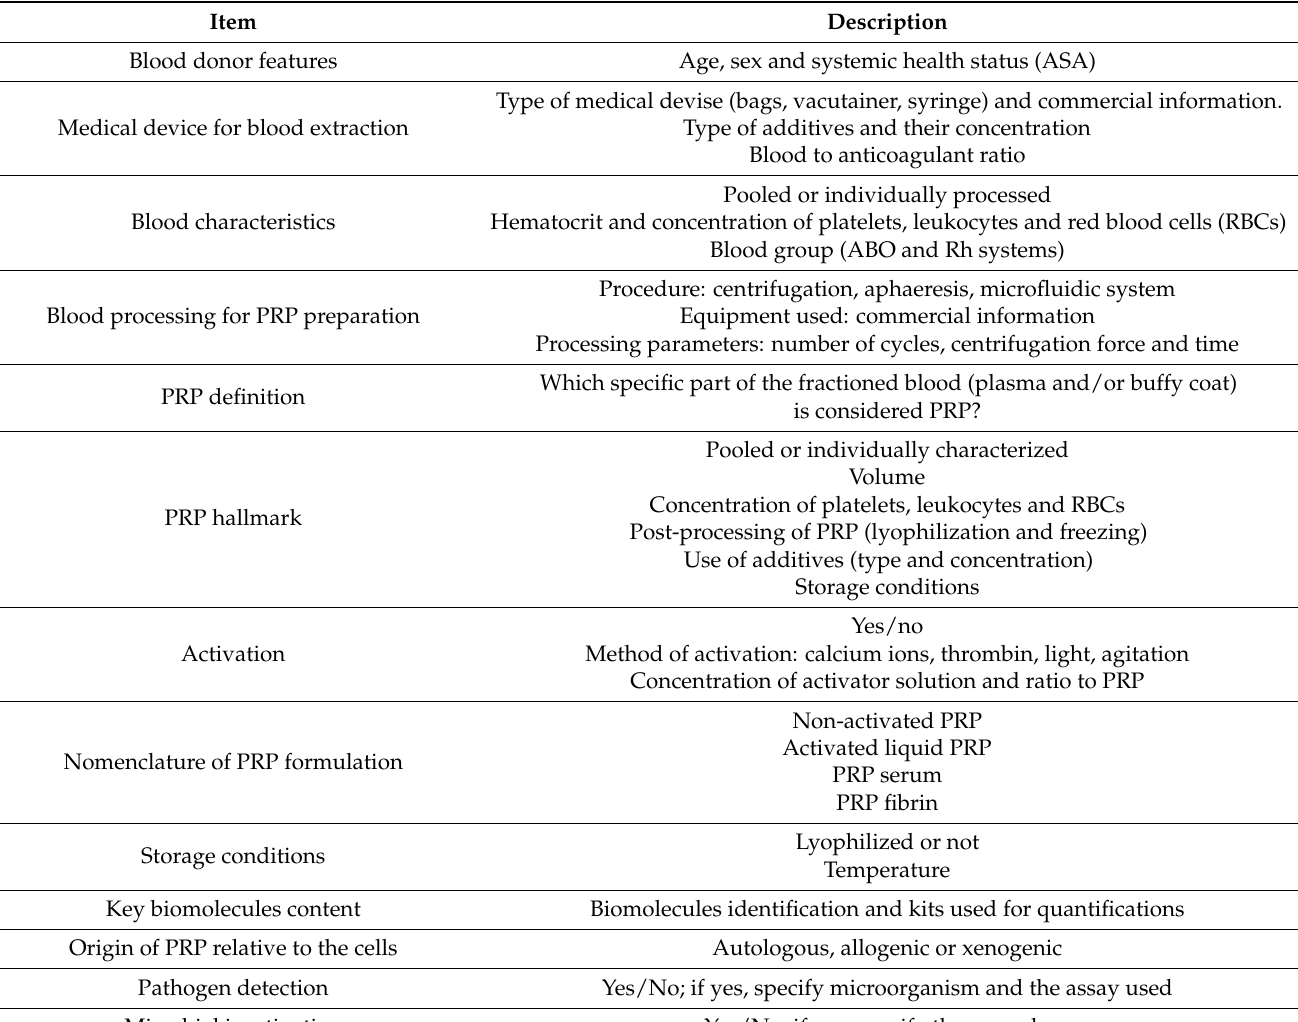
Table 3. Items for the transparent description of PRPs in research for cell therapy